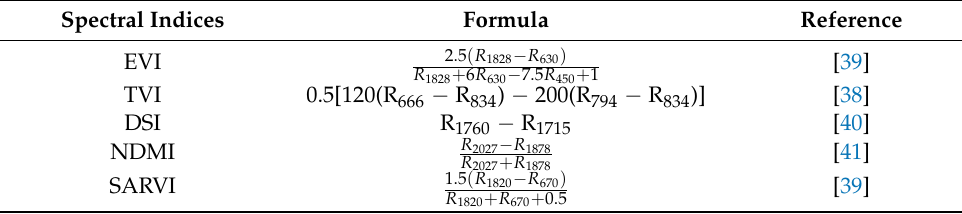
Table 1. The common spectral indices selected in this